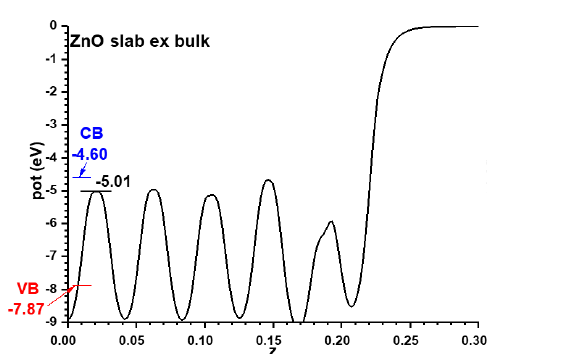
Figure 1. ( a ) Structure of fully relaxed ZnO, with (110) plane vertical and perpendicular to the draw- ing plane, displaying below it the curve of the plane-averaged Hartree potential together with the positions of the VB and CB. ( b ) the same for the anatase TiO 2 structure, with the (001) plane located in the same way. The band positions were obtained using the HSE06 functional with the indicated α values of Fock exchange fraction. z coordinate means, here and always, the ratio between atomic positions and cell dimension.